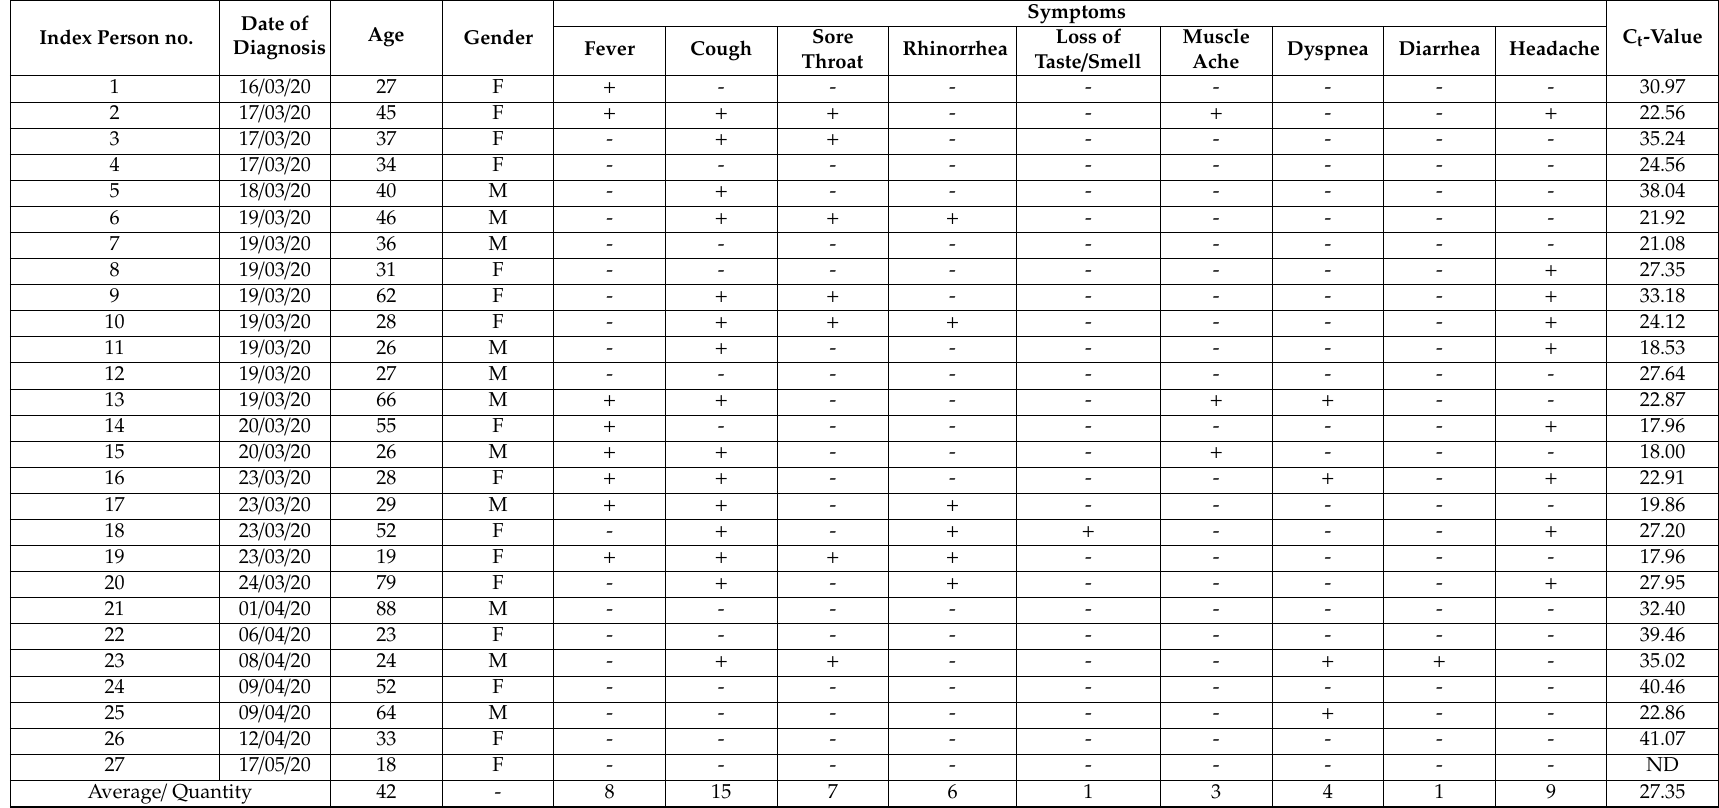
Table 1. Characteristics of index persons (HCW and patients) upon